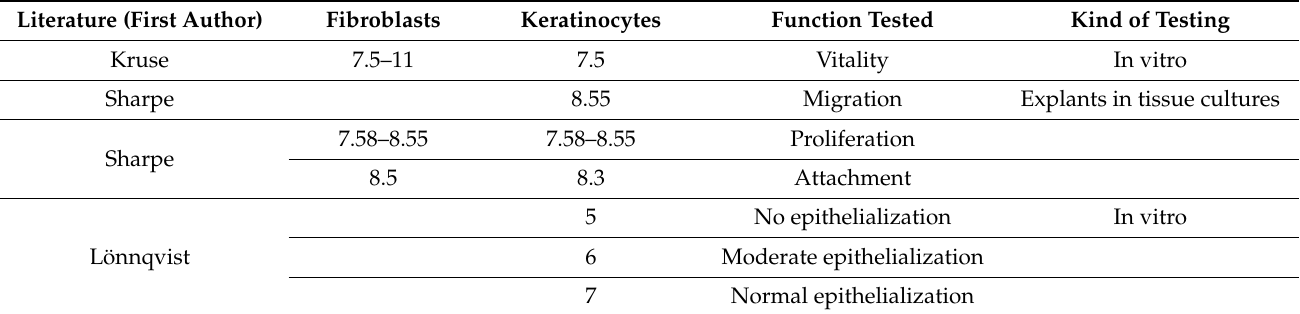
Table 1. Optimal pH for cells.